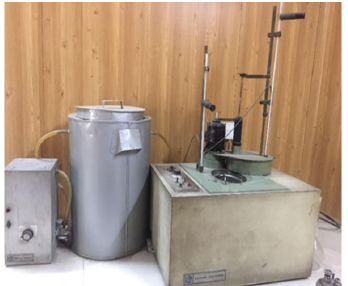
Figure 5. Bomb calorimeter for calorific values.